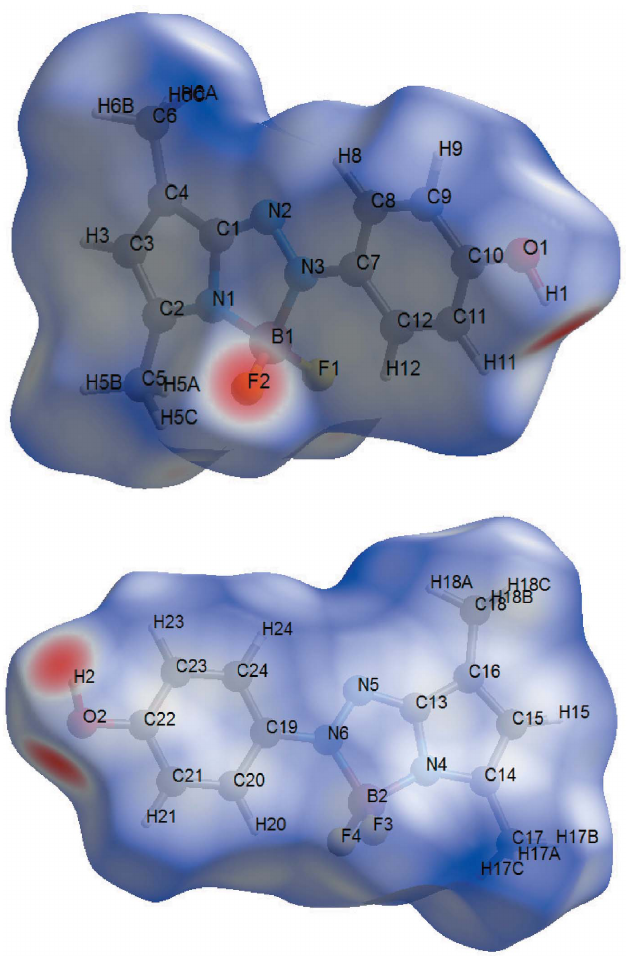
Figure 3 Hirshfeld surfaces of the two conformers mapped over d norm in the range (cid:3) 0.614 to 1.350 a.u. The intermolecular contacts can be seen in red regions.